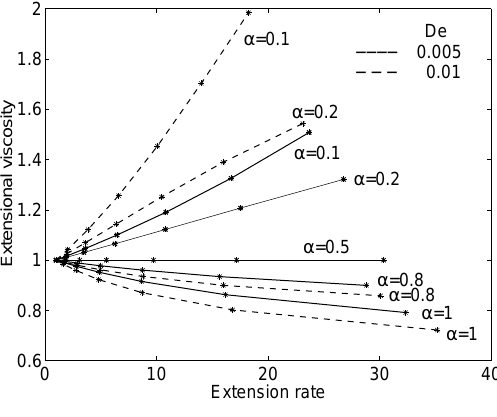
Figure 1. Extensional viscosity versus Extension